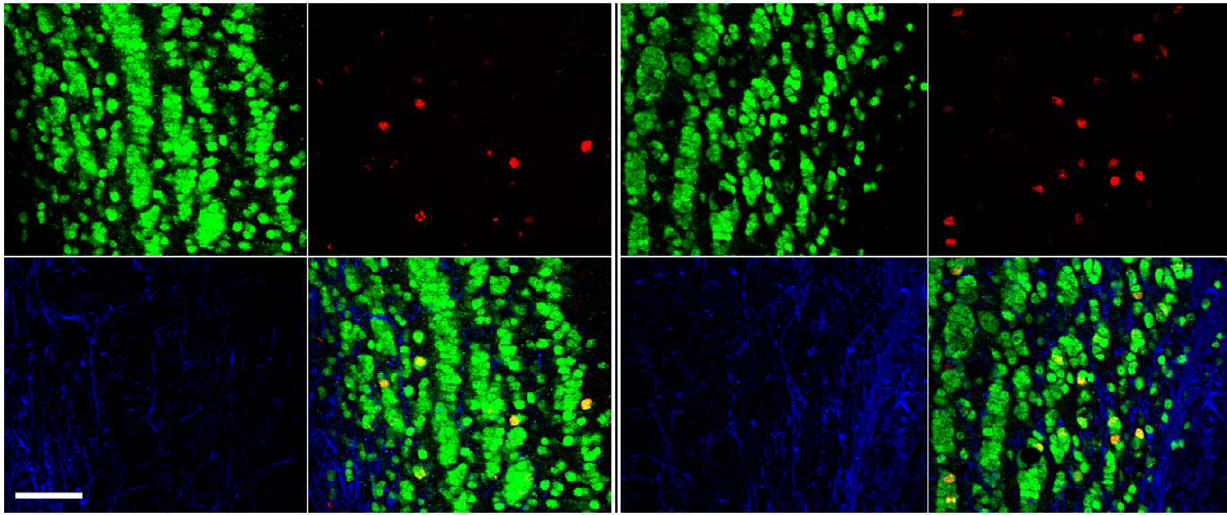
Figure 2. Olfactory bulb photomicrographs from LD (left panel) and SD (right panel) white-footed mice. Within each panel, clockwise from lower left: GFAP (blue), NeuN (green), BrdU (red), and merged images. Scale bar=50 m m.